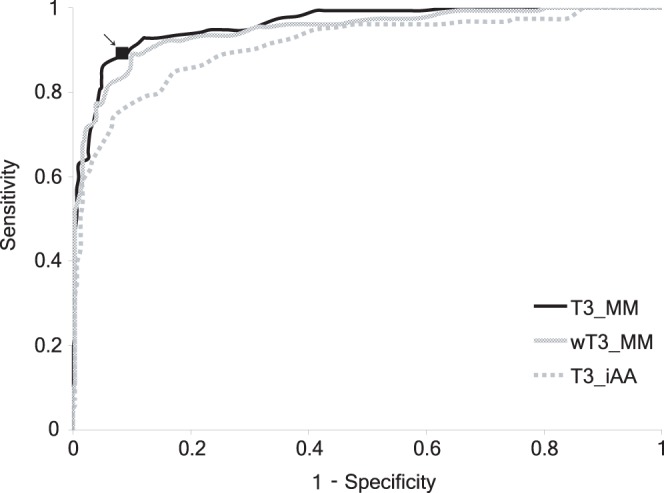
Receiver Operating Characteristic curves of different T3S protein classification models.The point of cutoff value (R = 0) was indicated with a black rectangle and an arrow.